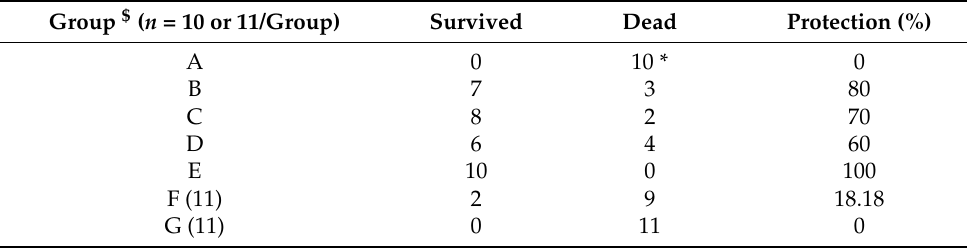
Table A1. Survival rate in different groups of experimental SPF chicken following challenge with virulent Newcastle disease